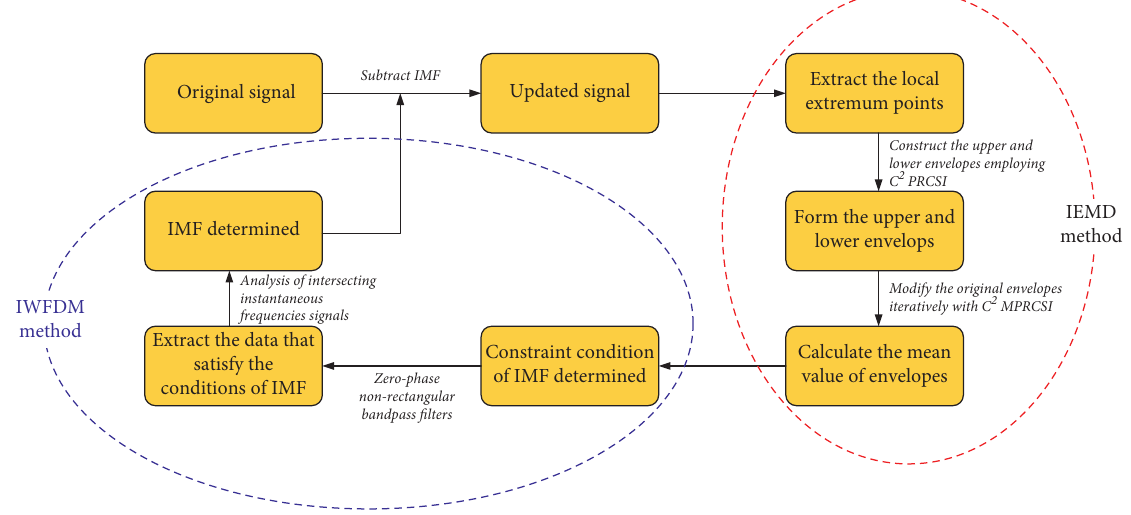
Figure 2: Procedure of IEMD-IWFD